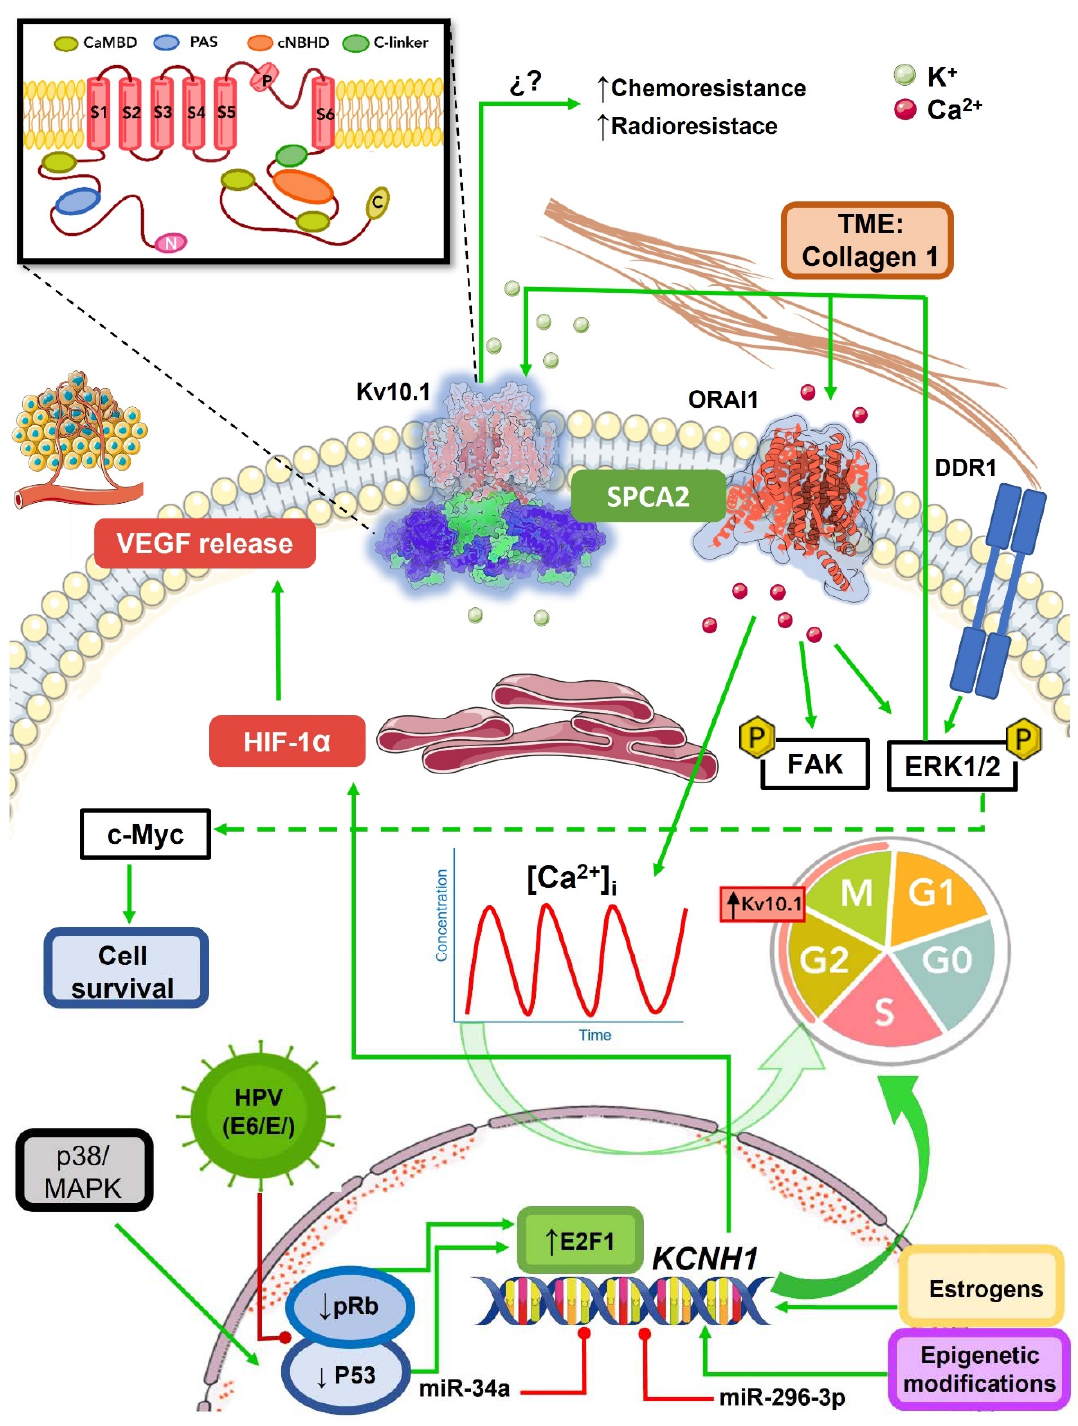
Figure 4. Schematic representation of Kv10.1 regulation in cancer. Kv10.1 is an ion channel permeable to K + (green spheres) mainly localized in the plasma membrane, but also is found in subcellular structures. The crystal structure of the Kv10.1 channel is embedded in the plasma membrane, with the transmembrane region in red and the intracellular N ‐ and C ‐ termini represented in purple and green, respectively. The figure in the upper left corner represents a Kv10.1 subunit; transmembrane segments (S1–S6) are represented in red, the N ‐ termini PAS domain in blue, the C ‐ linker in green, the cNBDH in orange, and the 3 CaMBD in olive. A functional channel is assembled as a tetramer. Kv10.1 has been described as an oncogenic channel, exerting its effects through different hypothesized mechanisms. The canonical function of Kv10.1 consists of efflux K + and hyperpolarized mem ‐ brane potential. The membrane hyperpolarization increases the driving force for Ca 2+ , promoting